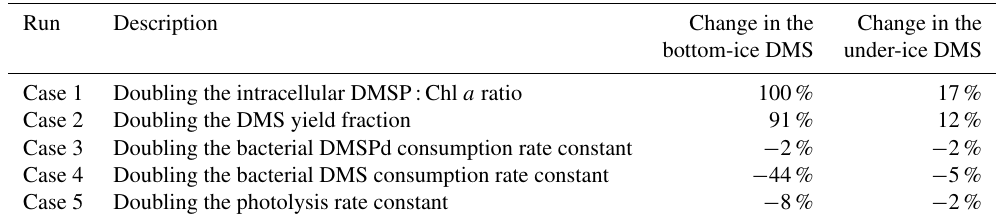
Table 4. Sensitivity of simulated bottom-ice and under-ice DMS to doubling the model parameter of the sea-ice sulfur cycle. Changes in the bottom-ice and under-ice DMS were calculated by subtracting the time-integrated DMS in the sensitivity run from the time-integrated DMS in the standard run and dividing the difference by the time-integrated DMS in the standard